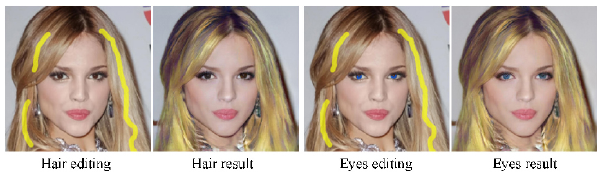
Fig. 2 Examples of color editing using our